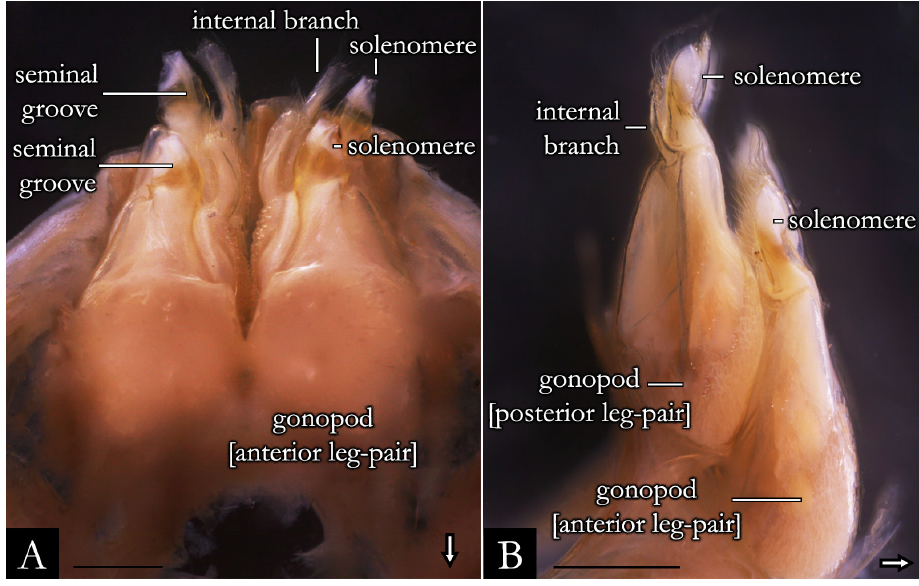
Fig. 38. Duplicate gonopods of Pseudonannolene robsoni Iniesta & Ferreira, 2014 (ISLA). A . Oral view. B . Ectal view. Scale bars = 0.5